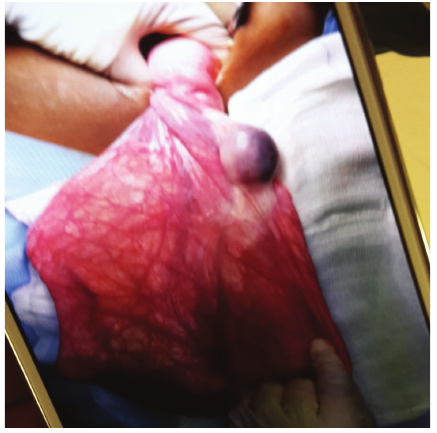
Figure 3: Intraoperative